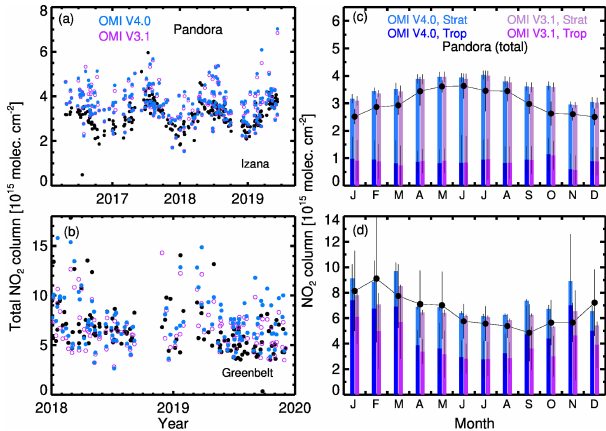
Figure 13. The time series of NO 2 total columns retrieved from Pandora (black circles) and OMI at (a) Izaña, Spain, and (b) Green- belt, Maryland, USA, with the OMI retrievals represented by the filled blue (V4.0) and open purple (V3.1) circles. Right panels show the monthly variation of NO 2 total columns at (c) Izaña for 2016– 2019 and (d) Greenbelt for 2018–2019, as calculated from Pandora (black line with filled circles) and OMI measurements (bars). OMI NO 2 total columns retrieved with V4.0 (blue) and V3.1 (purple) are separated into tropospheric and stratospheric components. The ver- tical lines represent the standard deviation from the